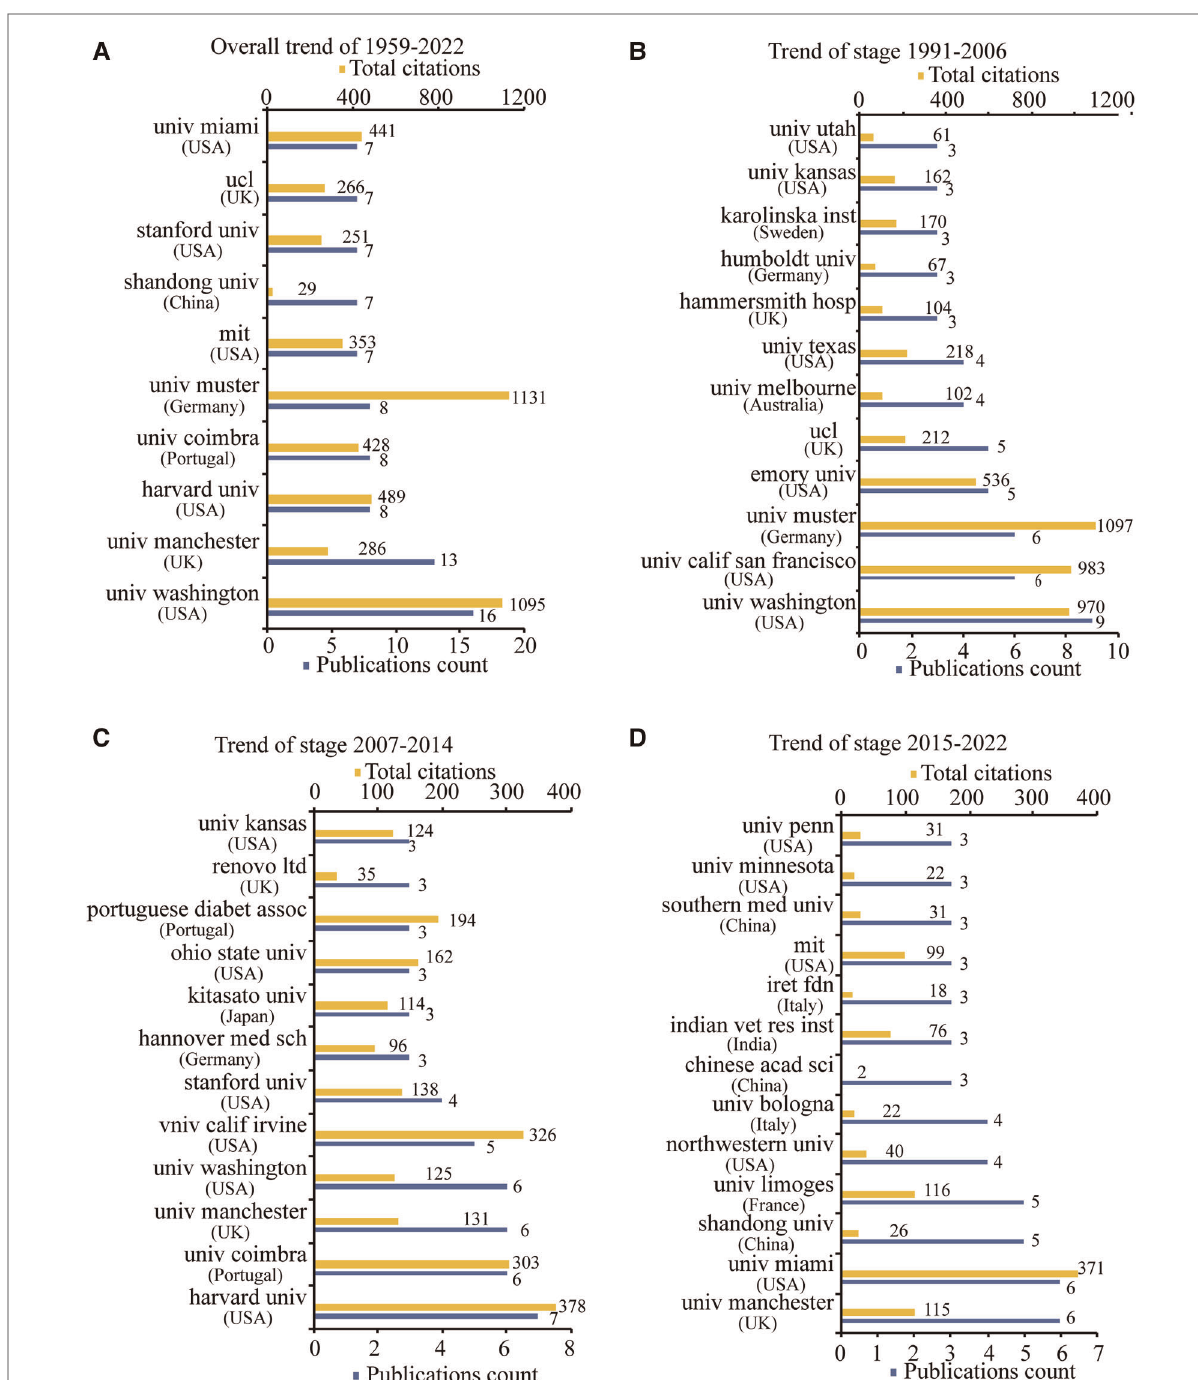
FIGURE 5 The top 10 productive institutions ordered by publications count. ( A ) The publications count and total citations of the top 10 institutions from 1959 to 2022. ( B ) The publications count and total citations of the top 10 institutions from 1991 to 2006. ( C ) The publications count and total citations of the top 10 institutions from 2007 to 2014. ( D ) The publications count and total citations of the top 10 institutions from 2015 to